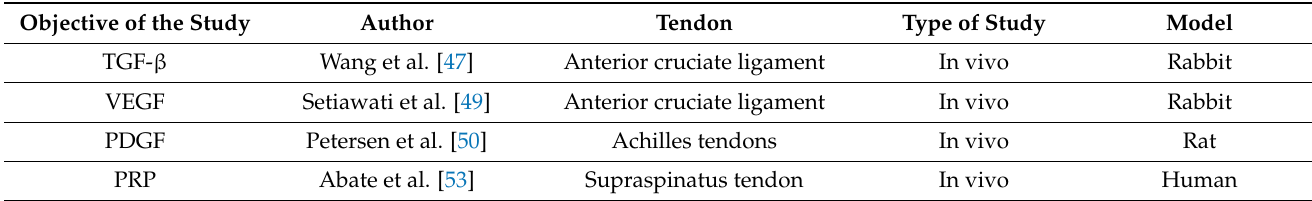
Table 2. Summary of clinical studies using cytokines for tendon